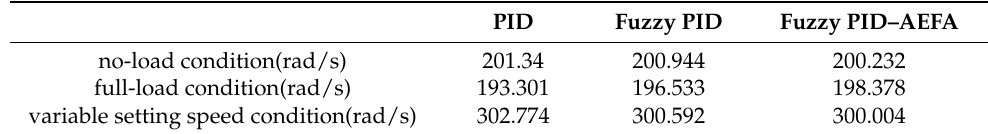
Table 4. The peak value of the three